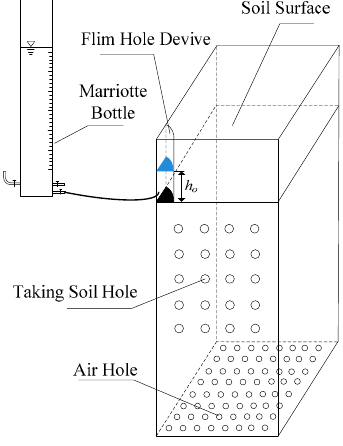
Figure 1. Simplified experimental setup ( h 0 represents irrigation depth).